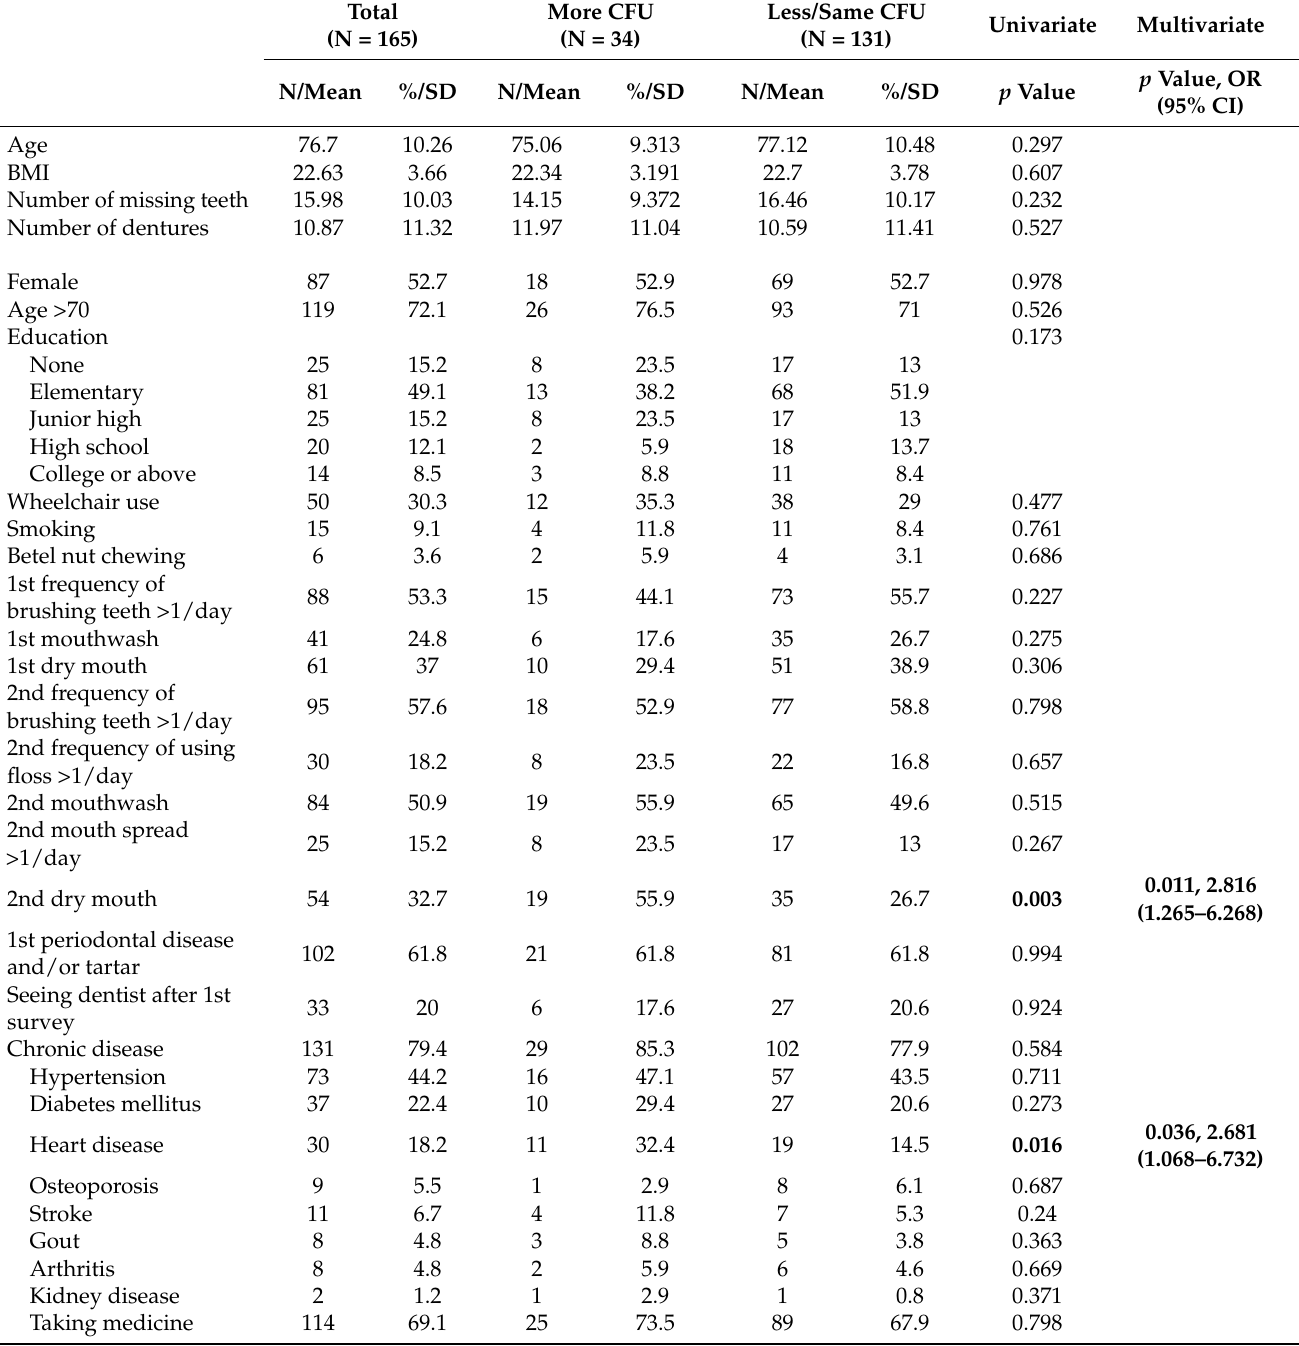
Table 3. Risk factors for higher density of colonizing